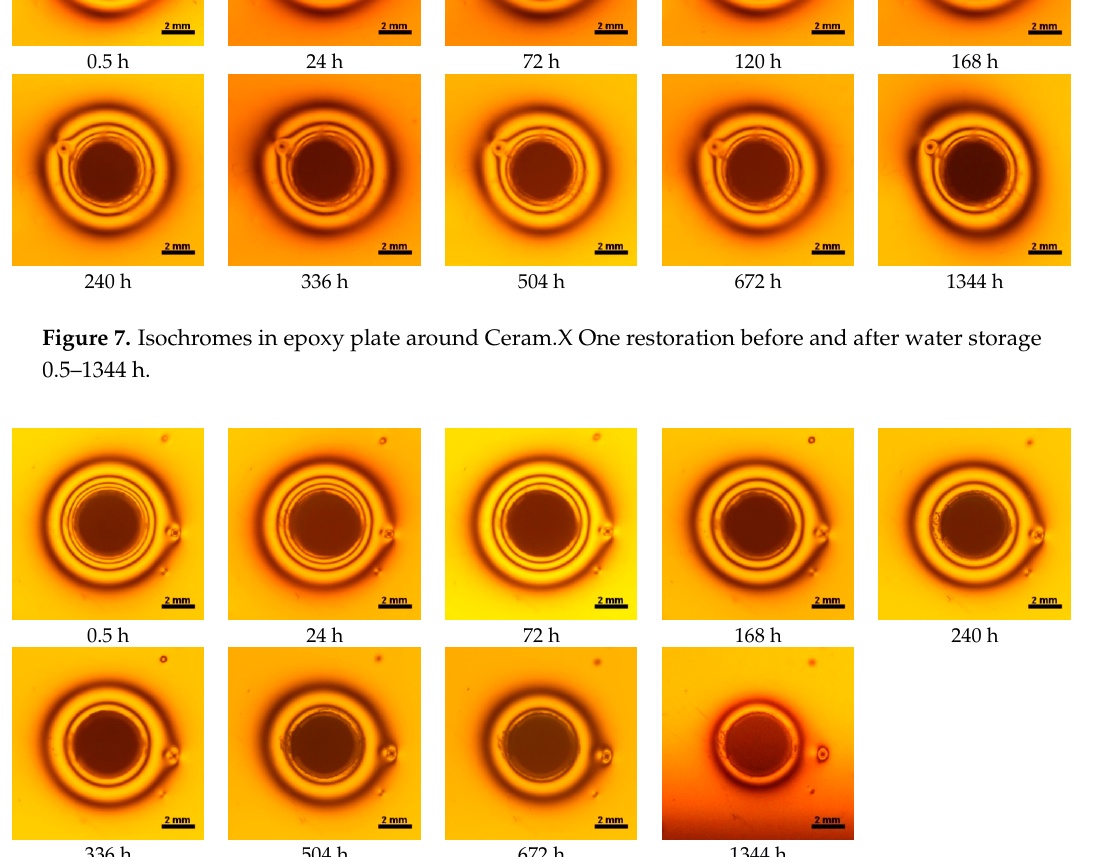
Figure 8. Isochromes in epoxy plate around Gradia Direct LoFlo restoration. Images acquired in polarized light with parallel polarization facets before and after water storage 0.5–1344 h.